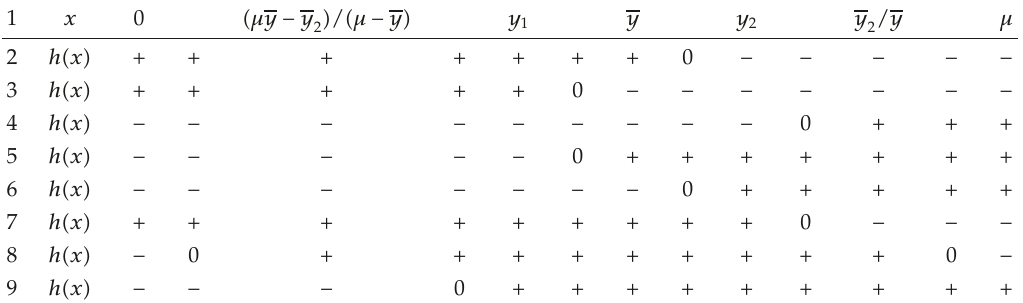
Table 2: The sign of the function h (cid:8) t − t